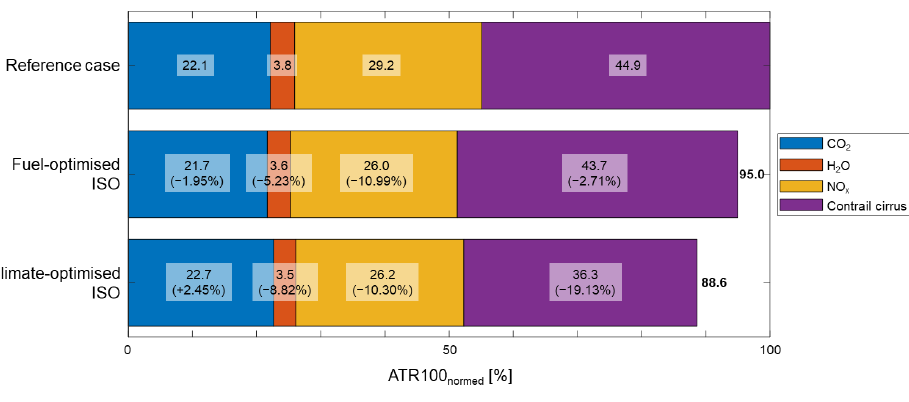
Figure 10. Change in ATR100 per emission species for fuel and climate-optimised ISO compared to the non-stop reference case at constant flight level of 35,000 ft.